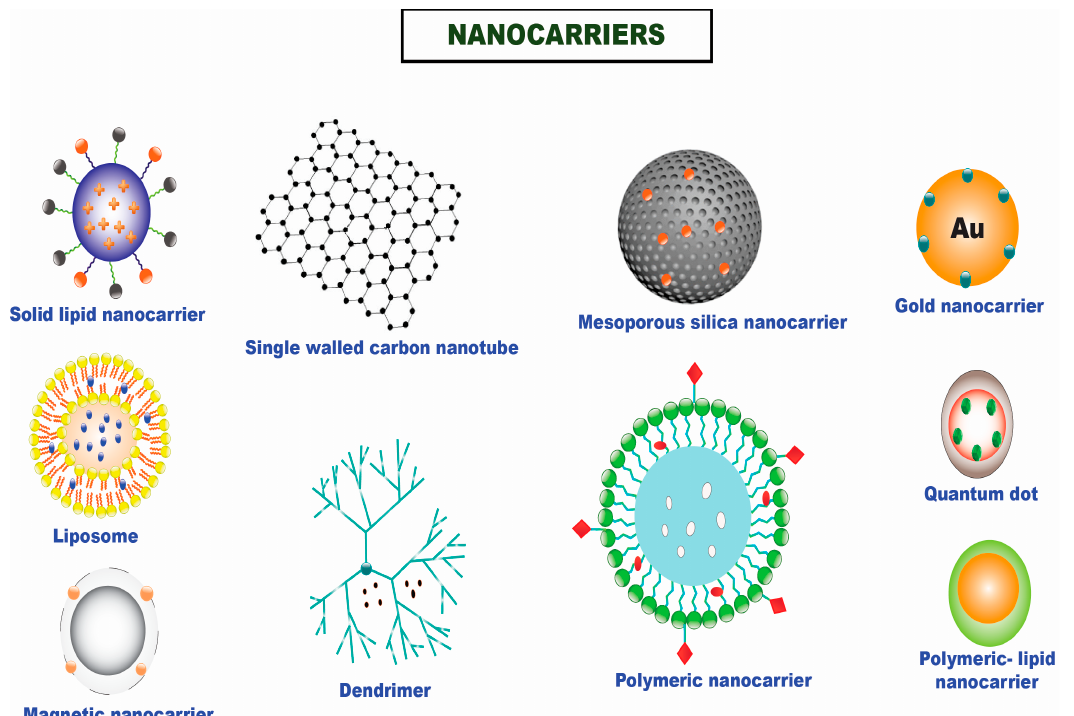
Figure 1. Different nanocarriers that are utilized for the efficient delivery of chemotherapeutics in solid tumors.